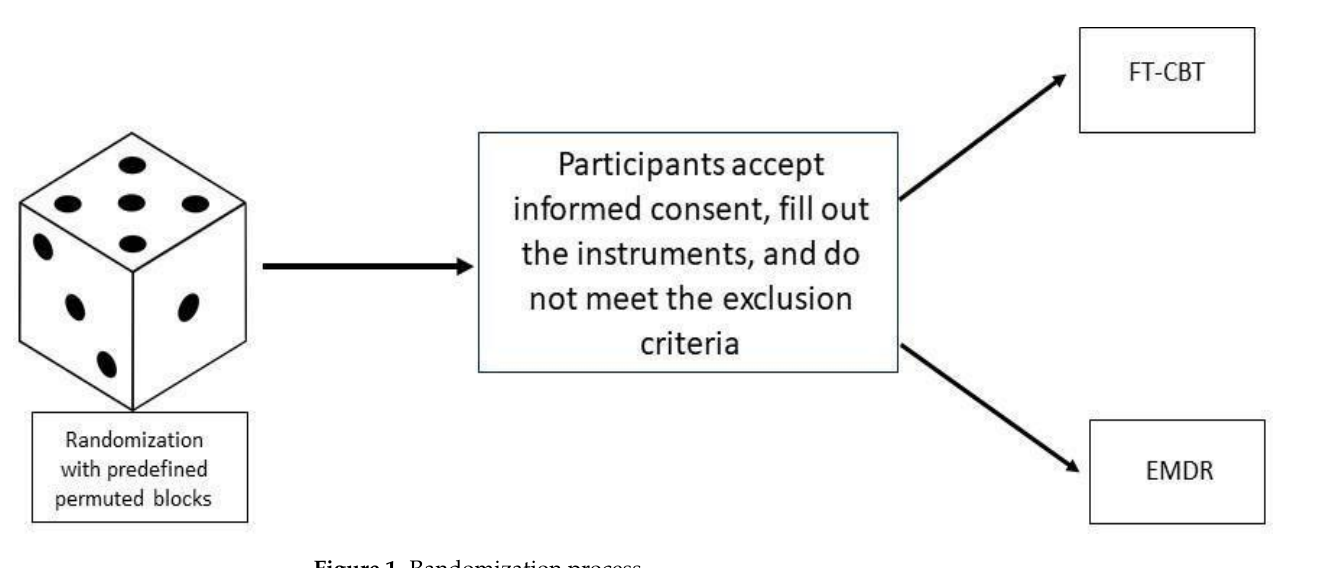
ADR generated the randomization, MJHJ registered the participants, and MJHJ allo- cated the participants to the two groups.